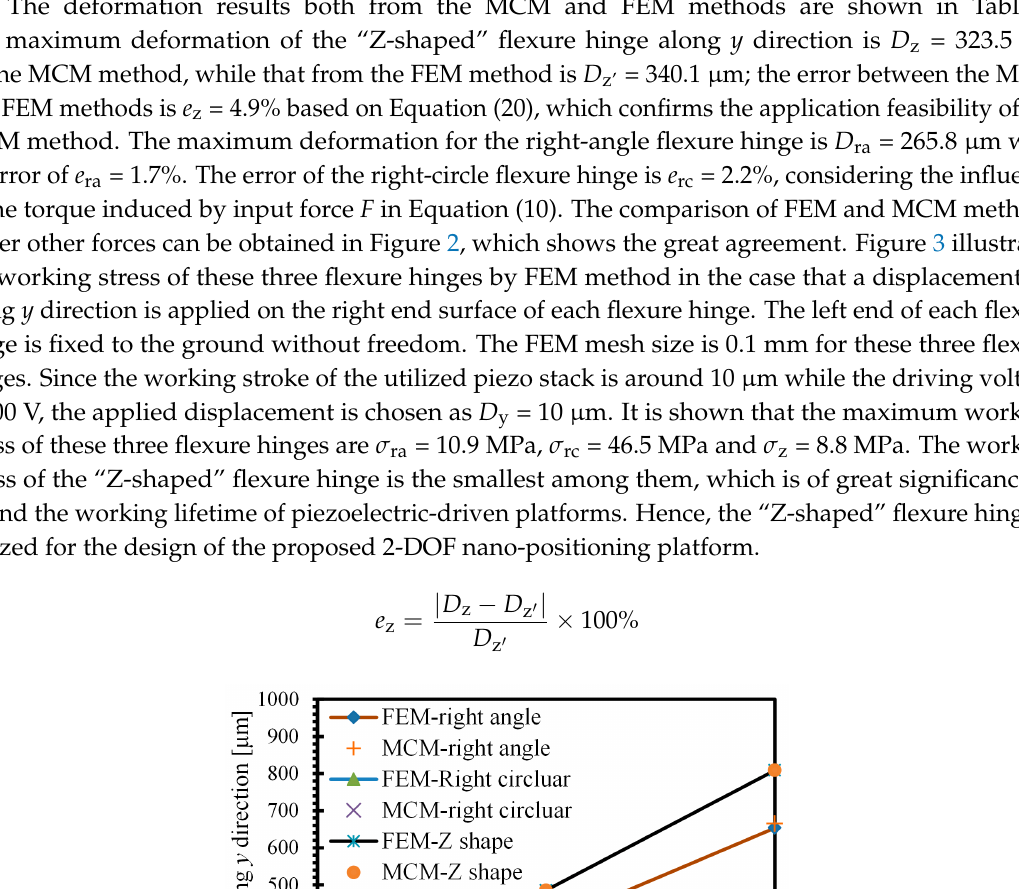
Figure 3. FEM results of different flexure hinges: ( a ) right-angle; ( b ) right-circle; ( c ) “Z-shaped”. 2.2. Platform Design Based on “Z-shaped” flexure hinges, a 2-DOF piezoelectric-driven platform has been proposed and manufactured. The parallel-six-connecting-rods structure is applied both in x -stage and y -stage instead of the generally used parallel-four-connecting-rods, and it is helpful to enhance the output stiffness of the whole platform. Additionally, it makes the platform more stable and the coupling error smaller, since the stiffness of x - and y -stages is enhanced to reduce coupling deformation of reaction forces. FEM method is also used to calculate the performance of the proposed 2-DOF piezoelectric-driven platform. During the FEM calculation, the four holes on the base corners are fixed to the ground without motion degrees of freedom; an input force F = 50 N was applied on x - stage in the surface to nest the piezoelectric stack; meanwhile, the reaction force F r = 50 N was also applied on the surface to nest the piezoelectric stack on y -stage. Figure 4 illustrates the results of FEM calculation. In the case that all the six-connecting-rods for y -stage are “Z-shaped” flexure hinges, the deformation of area A in y -stage is about 3 μ m, as shown in Figure 4a. Since the piezoelectric stack for x direction is nested inside y -stage, the reaction force makes the y -stage generate this unwanted deformation, which should be avoided. Meanwhile, in the case that two right-angle flexure hinges are utilized to replace “Z-shaped” flexure hinges for y -stage, the unwanted deformation of area A is rather small since the stiffness of right-angle flexure hinge along x direction is higher than the “Z- shaped” flexure hinge. Additionally, the output force of the used piezoelectric stacks is around F stack = 800 N, which is large enough to reduce the influence of the increased stress for y -stage motion stroke. Therefore, both “Z-shaped” flexure hinges and right-angle flexure hinges are utilized in the 2-DOF piezoelectric-driven platform.